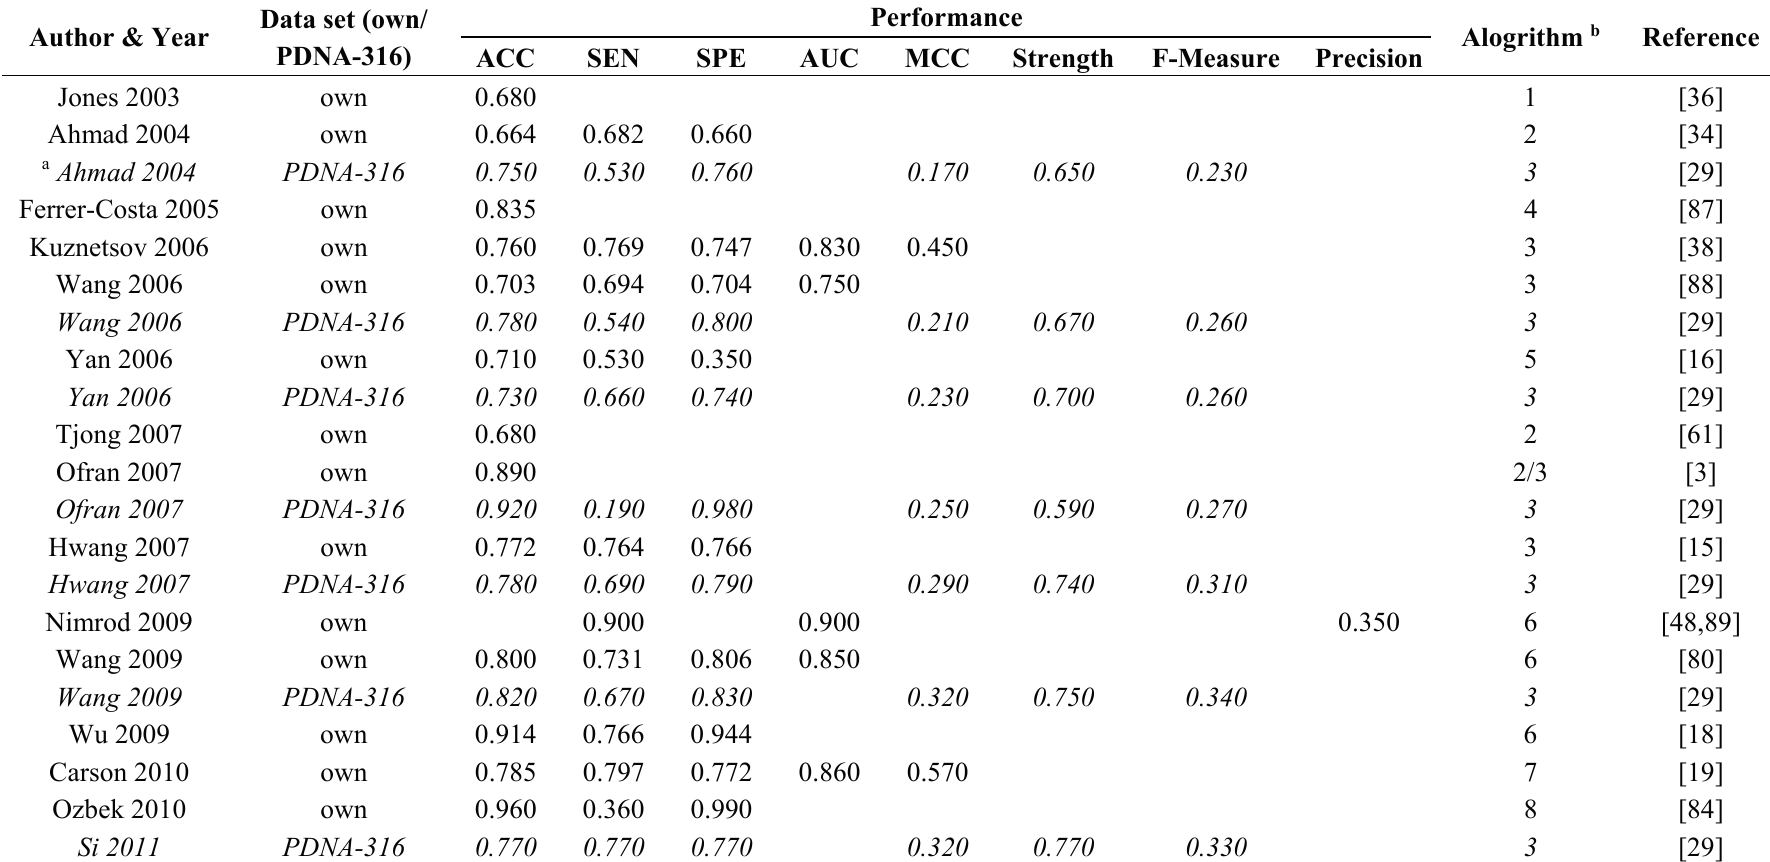
Table 3. Performance of the state-of-the-art methods for DNA-binding site